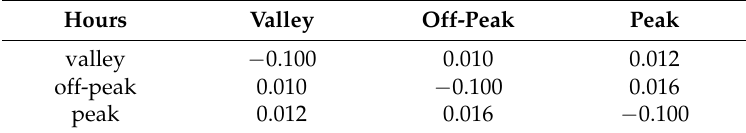
Table 2. The price elasticity